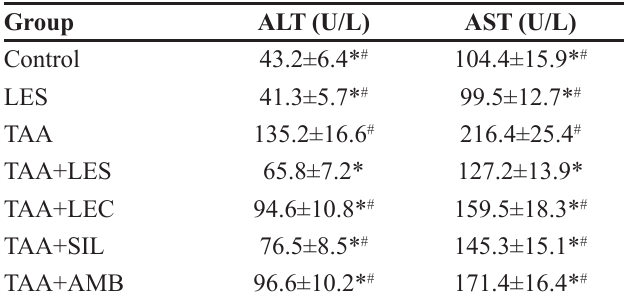
TABLE II - Effect of TAA, Lesimarin and its constituents on